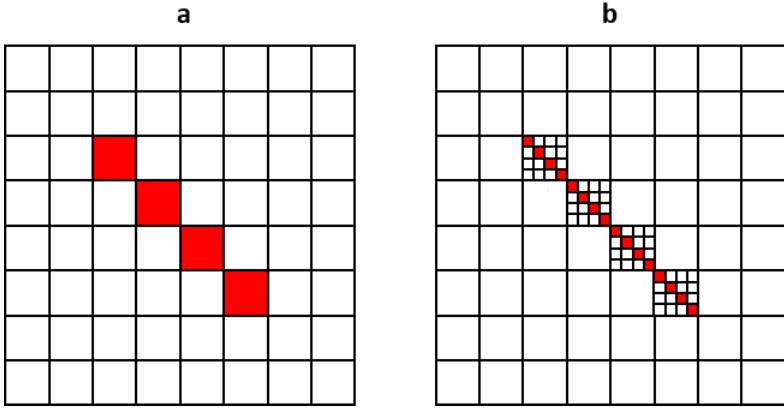
Figure 3. 2D representation of a dislocation loop in a tilted plane on a ( 8 × 8 ) fast Fourier transform (FFT) grid: ( a ) with a homogeneous eigenstrain ε ∗ in the voxels occupied by the dislocation loop; ( b ) with each voxel subdivided into 4 × 4 sub-voxels, only 4 of which have a 4 ε ∗ eigenstrain